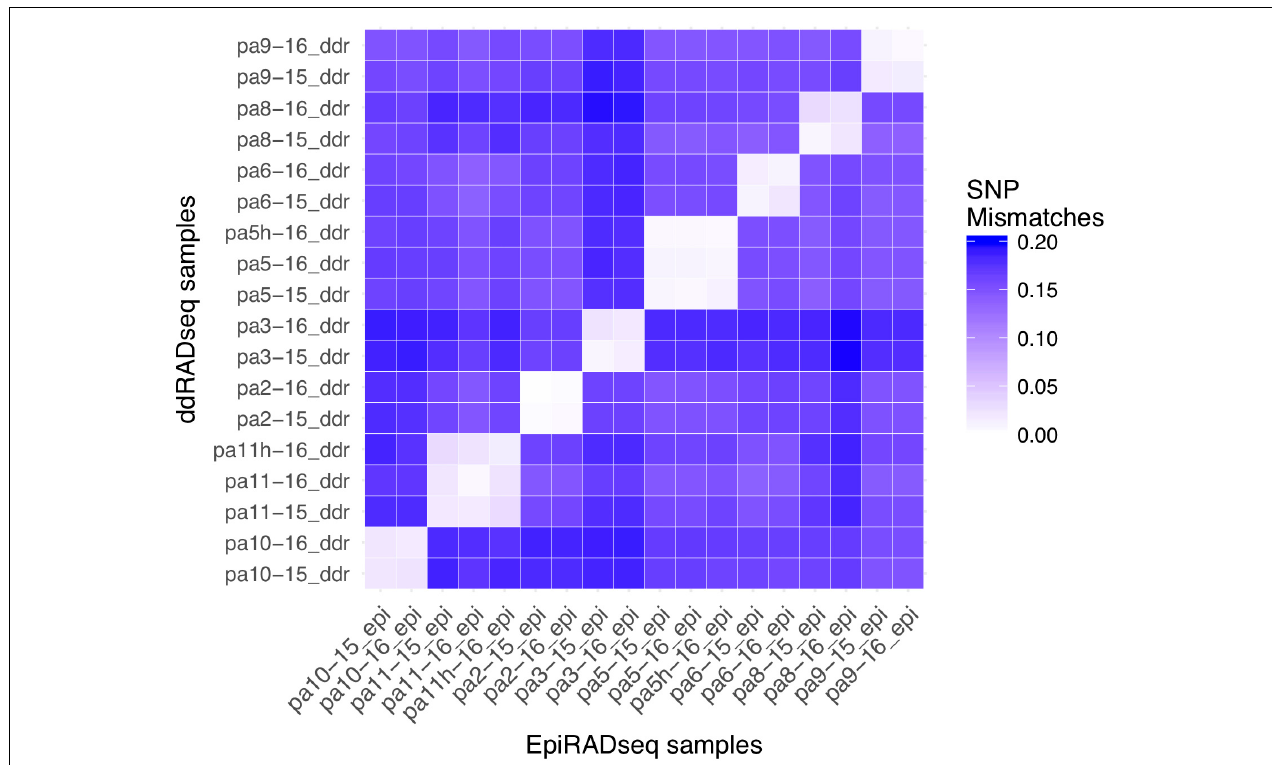
FIGURE 3 | Pairwise SNP mismatches between the P. astreoides samples. EpiRADseq samples are shown along the x -axis, while ddRADseq samples are shown along the y -axis. Values along the diagonal illustrate the SNP error rate using the two libraries as technical replicates, while off-diagonal values show the error associated with resampling corals from 2015 to 2016. Two controls that were left at their site of origin (pa11h and pa5h) are included.